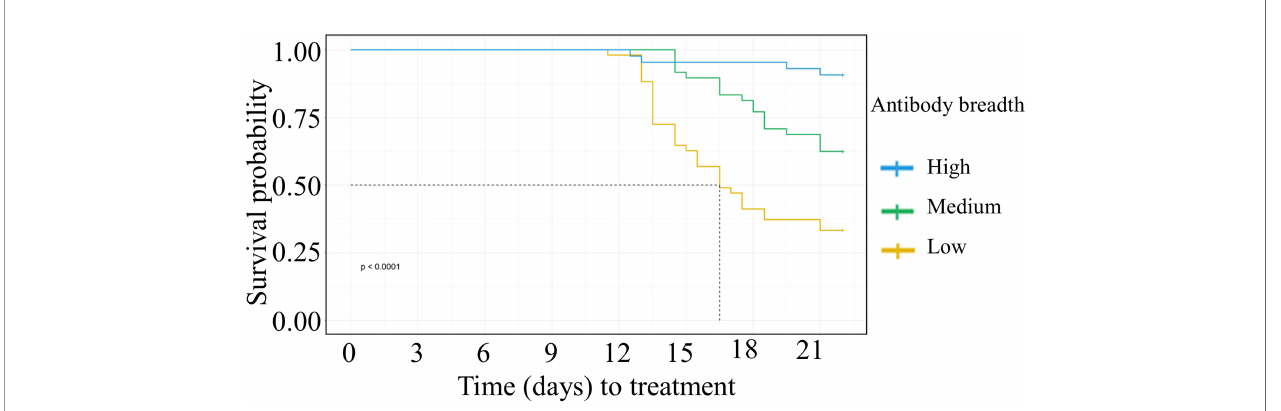
FIGURE 2 | Kaplan Meier survival analysis of time to treatment strati fi ed by individuals ’ breadth of anti-VSA antibodies at day C-1. The dotted line denotes the median survival time where the survival probability is below 50%. Medium breadth score: HR= 0.38(95%CI 0.21-0.67, p=0.0008). High breadth score: HR= (0.08 (95%CI 0.03-0.24,p=<0.0001).